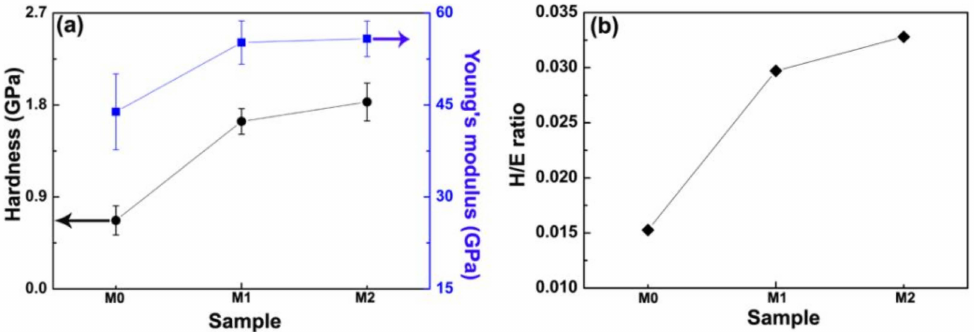
Figure 4. Hardness, elastic modulus ( a ) and H/E ratios ( b ) of all fabricated materials.